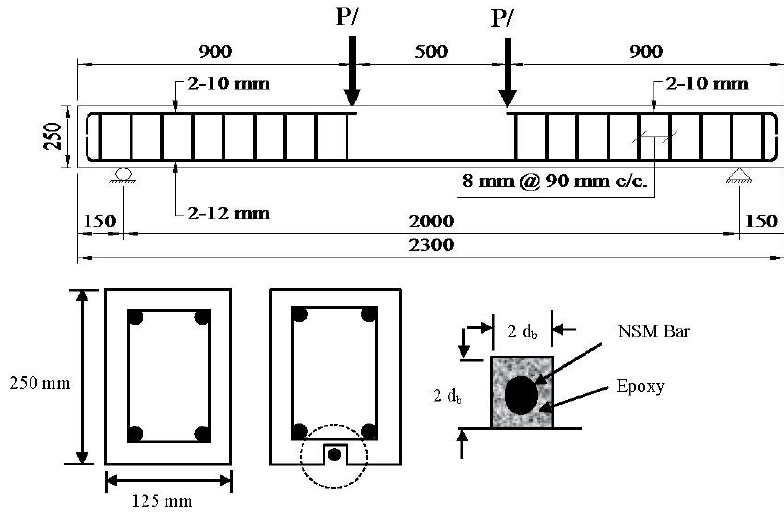
Figure 7. Specimen